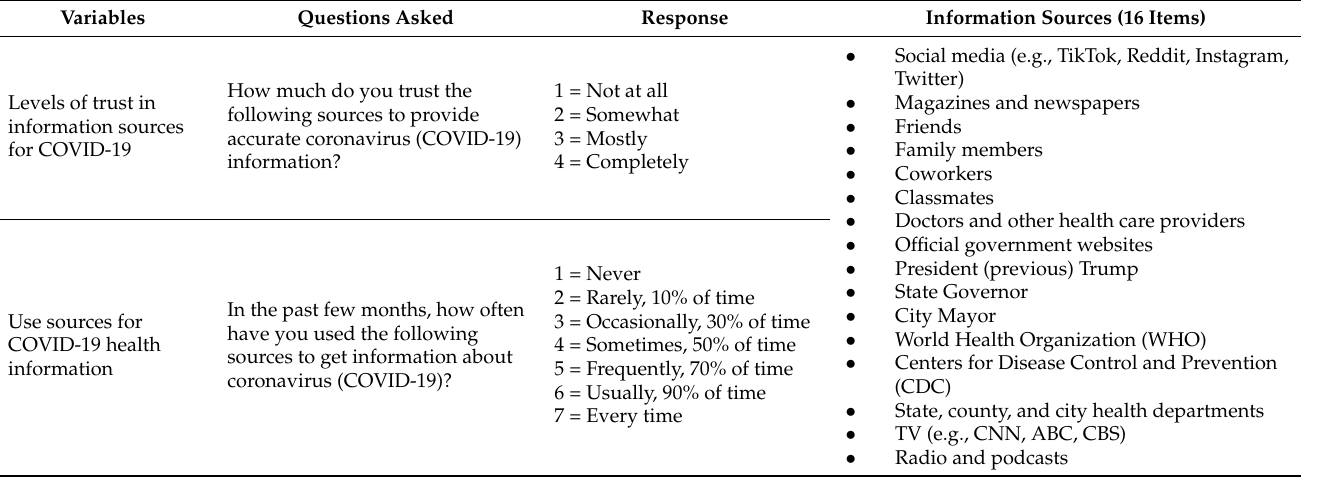
Table 1. Outcome variables, questions, information sources, and response